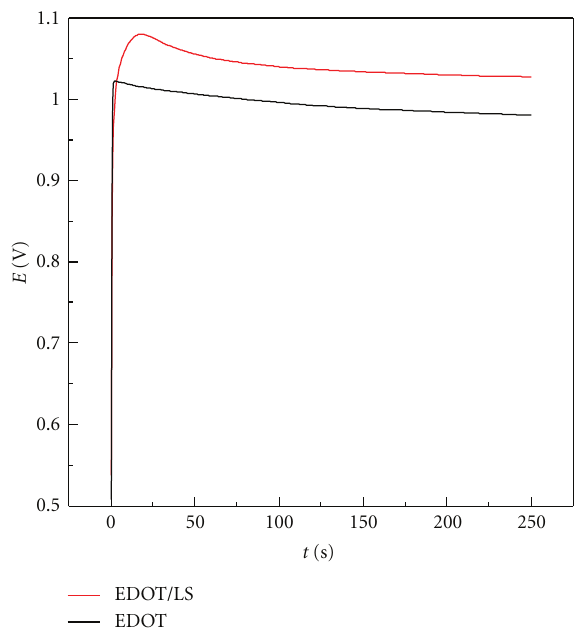
Figure 1: Voltage-time tracing recorded during galvanostatic po- lymerization of EDOT in the absence (black line) and presence of LS (red